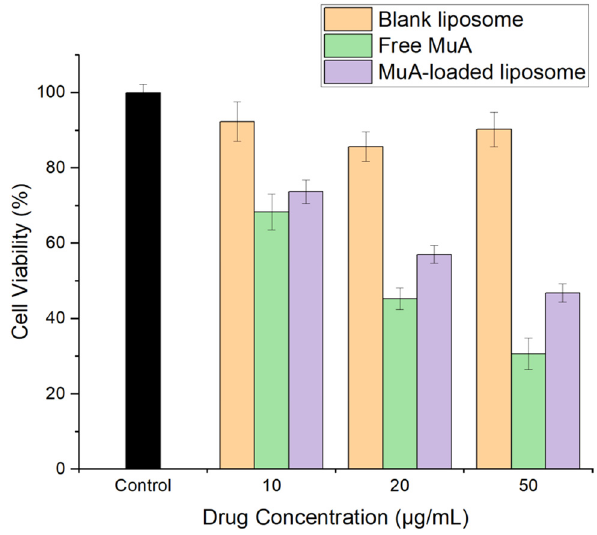
Figure 6: In vitro anti - tumor activity of blank liposomes, free MuA, and MuA - loaded